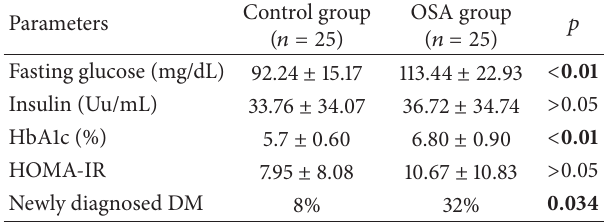
Table1:Demographiccharacteristicsandanthropometricmeasure- ments in control group versus OSA group.